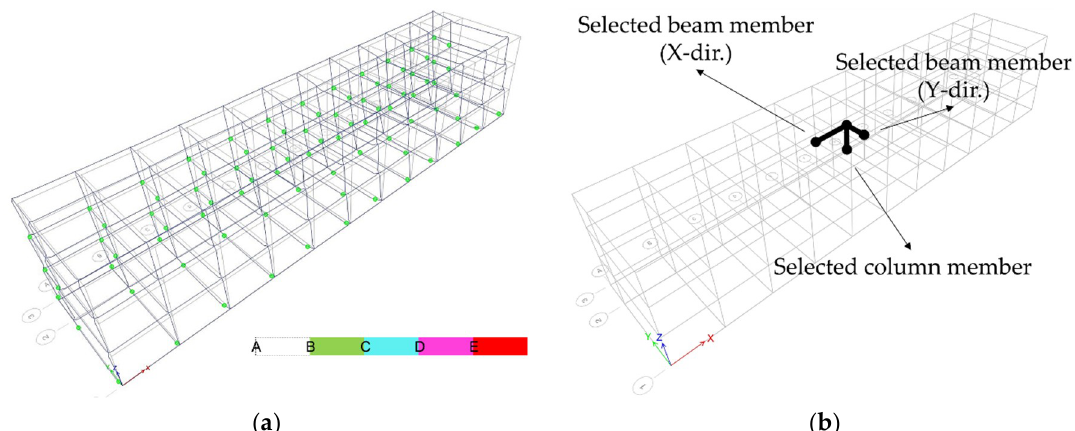
Figure 11. Type 1 (P.P, Northridge): ( a ) plastic hinge status and ( b ) selected structural members.